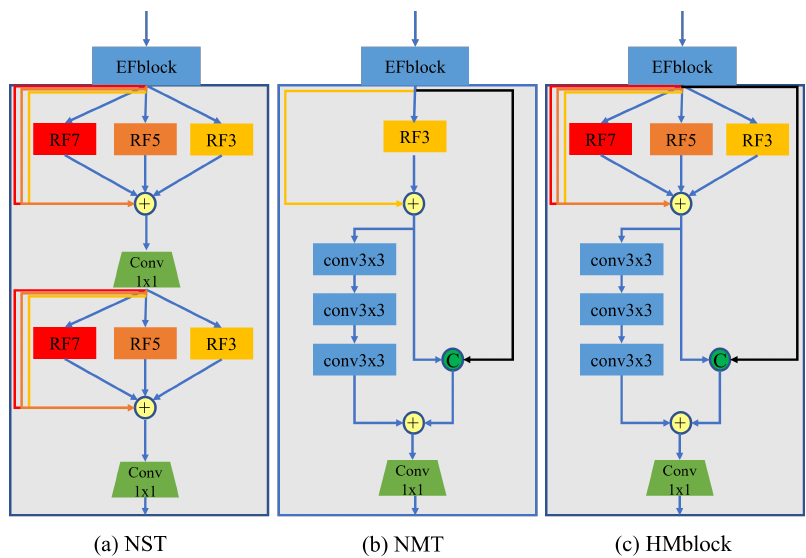
Figure 7. NST: without global multi-scale structural. NMT: without local multi-scale texture features. HMblock: complete hybrid multi-scale features.